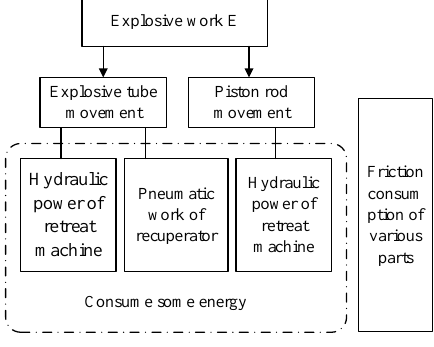
Fig. 3 . Block diagram of functional energy conversion for